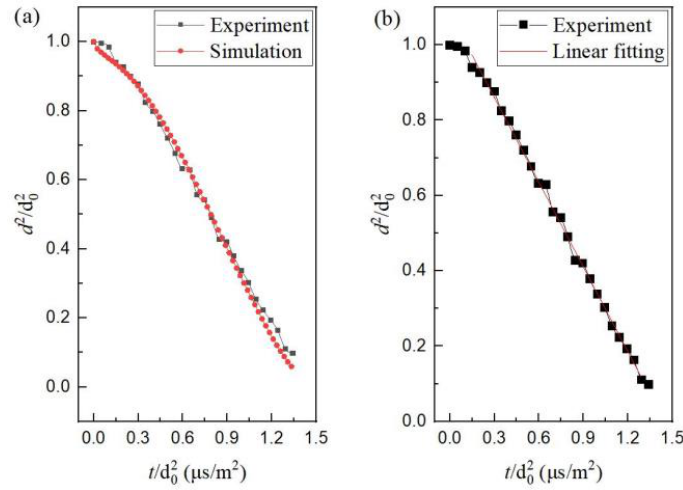
Figure 2. The experimental and calculated curves during transient heating and isothermal evapora- tion of n-decane; ( a ) the experimental and calculated results; ( b ) the experimental value and linear fitting result.